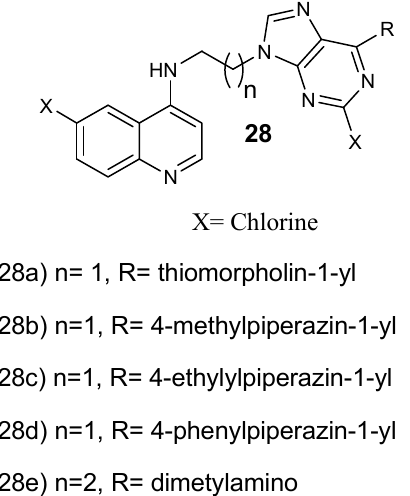
Figure 13. 4-aminoquinoline–sulfonamide and hydrazine hybrids 29a – f.